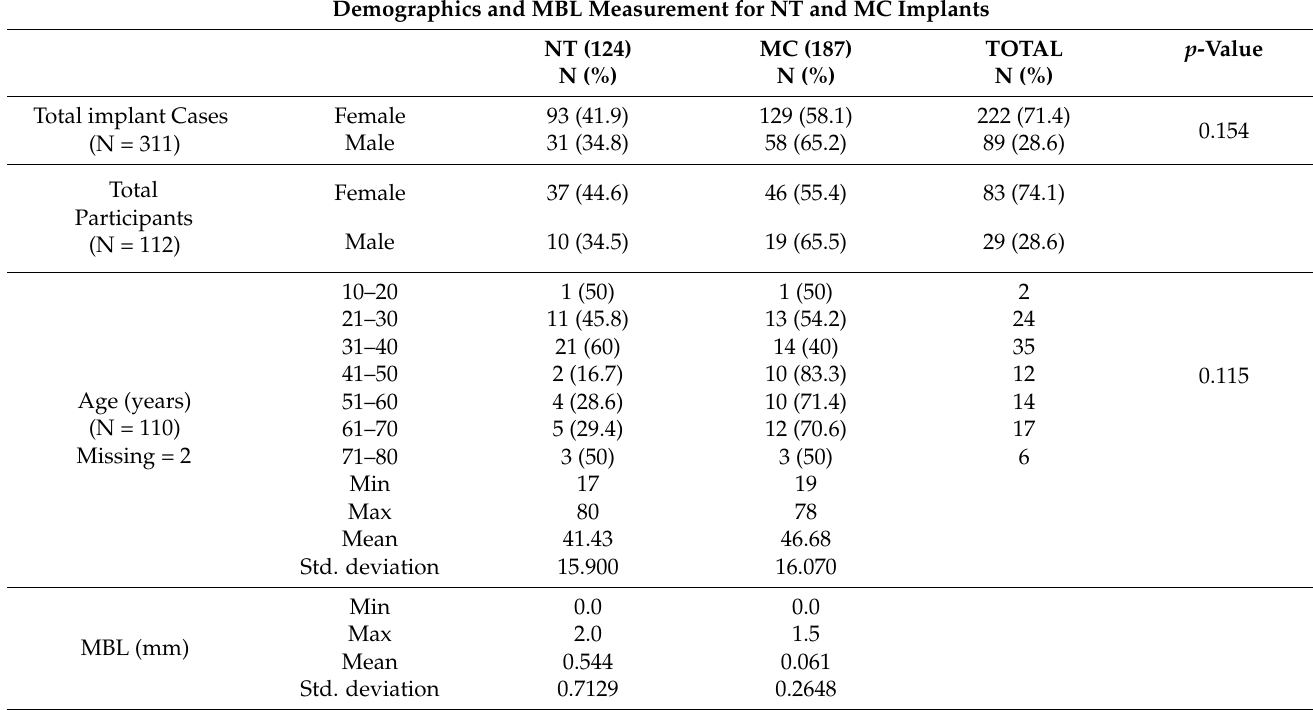
Table 1. Demographics and MBL measurement for NT and MC implants. Demographics and MBL Measurement for NT and MC